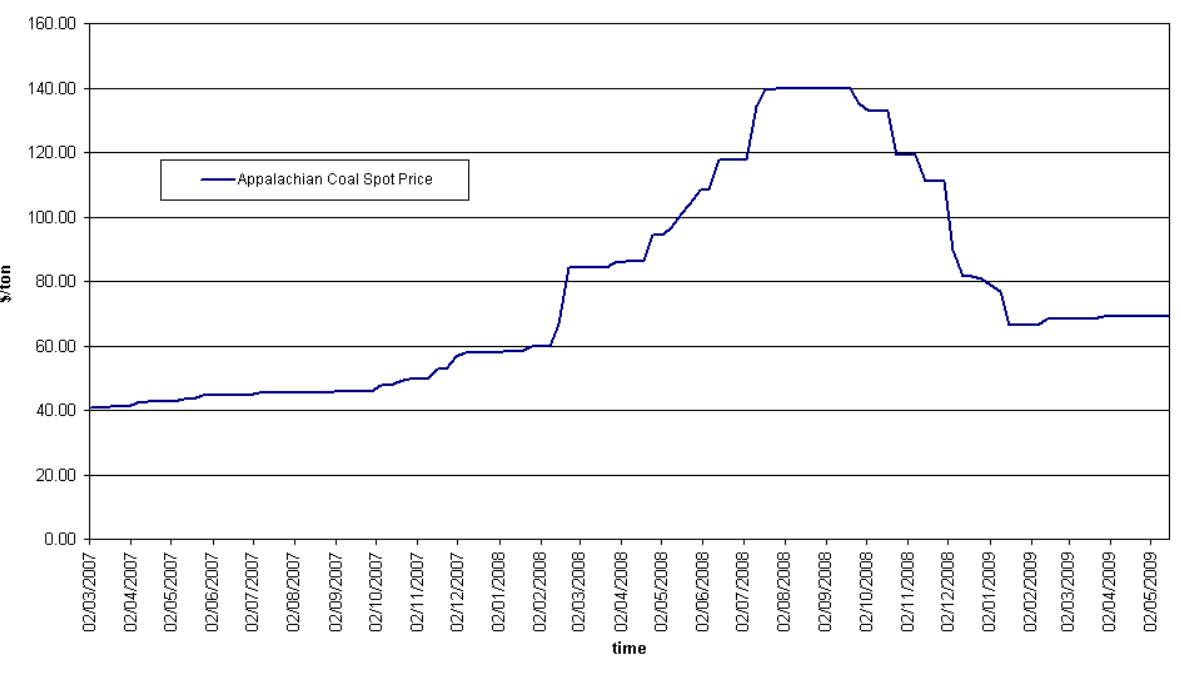
Figure 5. Spot price of Appalachian coal on